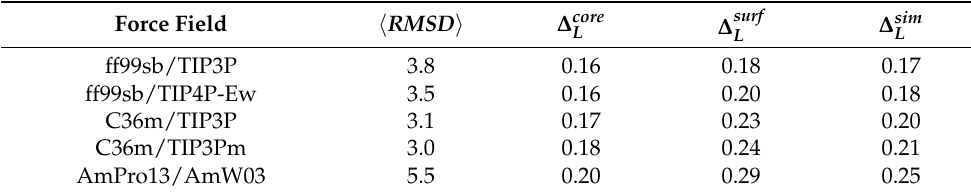
Table 2. Fluctuation properties of the TSR4 domain at 300 K. <RMSD> is the average root mean square distance to the starting structure of TSR4. A value of a = 4.375Å and <RMSF> averaged over all residues of TSR4 were used to calculate the total Lindemann value, ∆ sim L . ∆ core L was evaluated from the β -sheet core residues; ∆ surf was calculated from all protein residues not characterized as L core residues. ∆ sim ∆ surf Force Field (cid:104) RMSD (cid:105) ∆ core L L